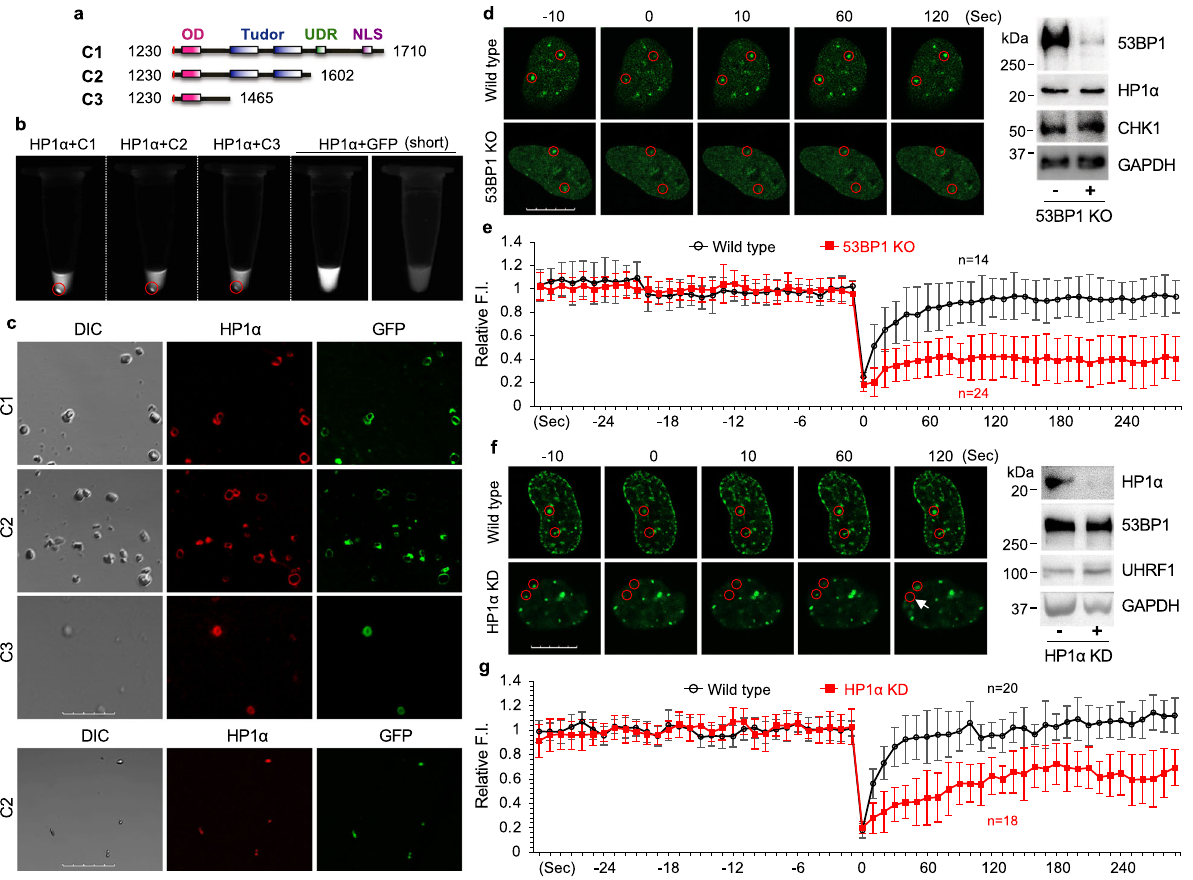
Fig. 5 LLPS of 53BP1 and HP1 α . a Generation of GFP-53BP1 fragments. b Puri fi ed proteins were mixed on ice, incubated at room temperature for 20 min, centrifuged at 10,000 g for 10 min and visualized by the Tanon 2500 Imager at 590 nm. Far Right: short exposure for the mixture of HP1 α and GFP. Red circles indicate precipitations after centrifugation. c Representative bright fi eld and single z-plane confocal images of liquid droplets formed by mGFP- 53BP1-C1, -C2 or -C3 with mCherry-HP1 α in vitro. Lower panel : smaller droplets. Scale bar is 40 μ m. d MCF-10A parental or 53BP1 KO cells were transfected with GFP-HP1 α for 48 h and FRAP was performed. Representative single z-plane confocal images are shown. Right: protein expression. The residual 53BP1 signal in the KO lane might have come from loading contamination. e FRAP analysis of cells in ( d ) from n = 14 and 24 events. f U-2 OS parental or HP1 α KD cells were transfected with GFP-53BP1-C1 for 48 h and FRAP was performed. Representative single z-plane confocal images are shown. Right: protein expression. The arrow indicates a 53BP1-C1 punctum that transiently recovered (60 s) but then disappeared (120 s). g FRAP analysis of cells in ( f ) from n = 20 and 18 events. The X -axis (time) in ( e ) and ( f ) is not scaled and 0 indicates photobleaching. Red circles in ( d ) and ( f ) indicate puncta that were bleached. Scale bars in ( e ) and ( f ) are 10 μ m. FRAP quantitation in ( e ) and ( g ) represent mean values and SD acquired from two independent